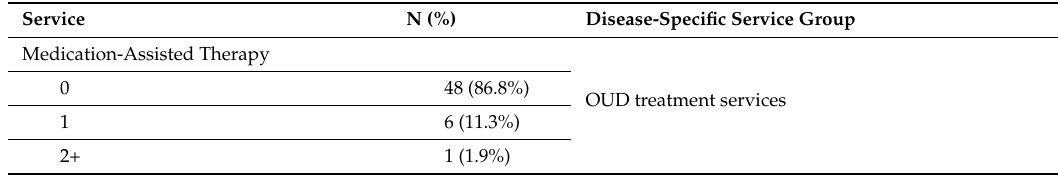
Table 2. Number of services by disease-specific service group reported by rural local health departments, Illinois, 2018.